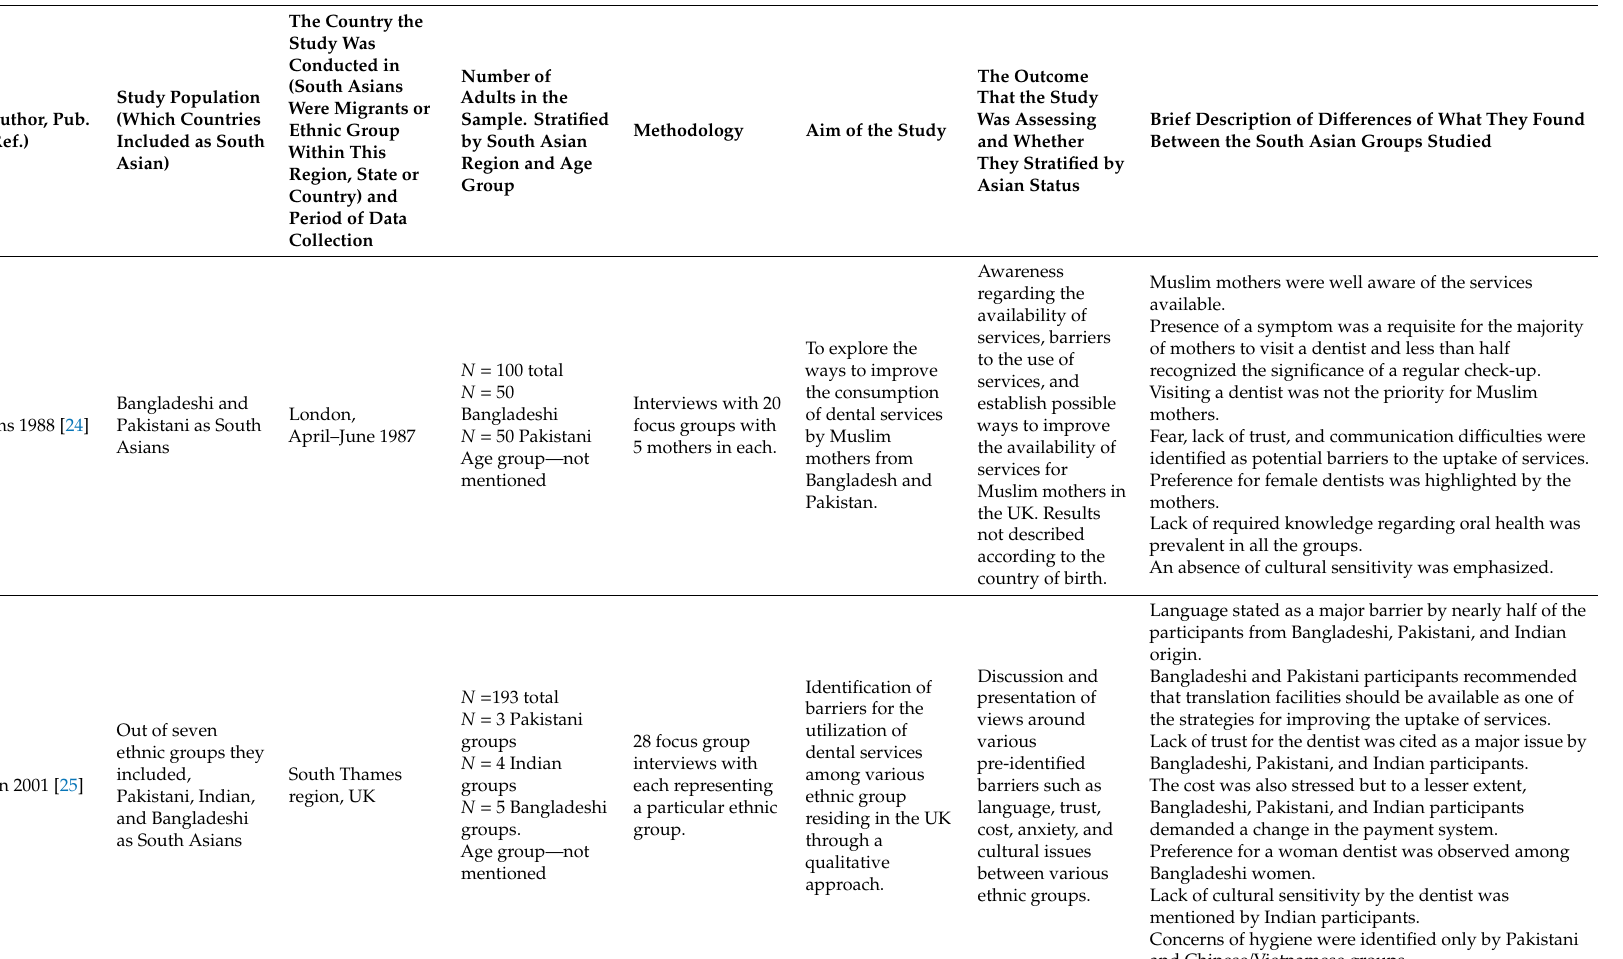
Table 2. Summary characteristics table of qualitative